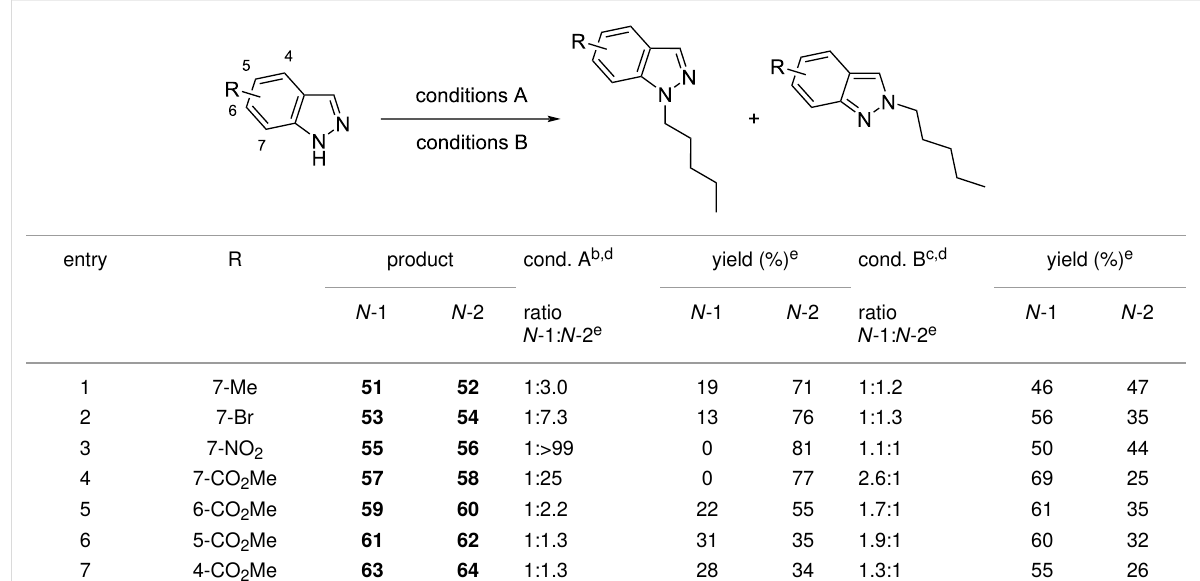
Table 4: Effect of indazole benzenoid ring substituents on N -1: N -2 regioselectivity. a